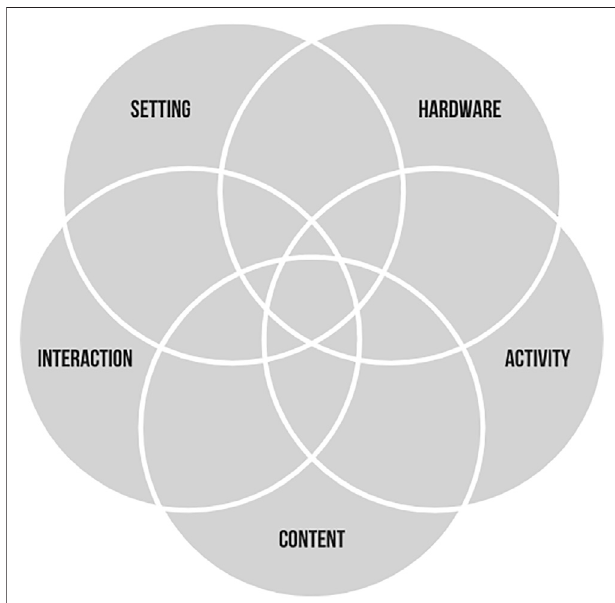
FIGURE 2 | SHACI VR design framework. The overlapping circles are intendedtorepresentthe waythat decisions in onearea oftheframeworkcan in fl uence choices in other areas.